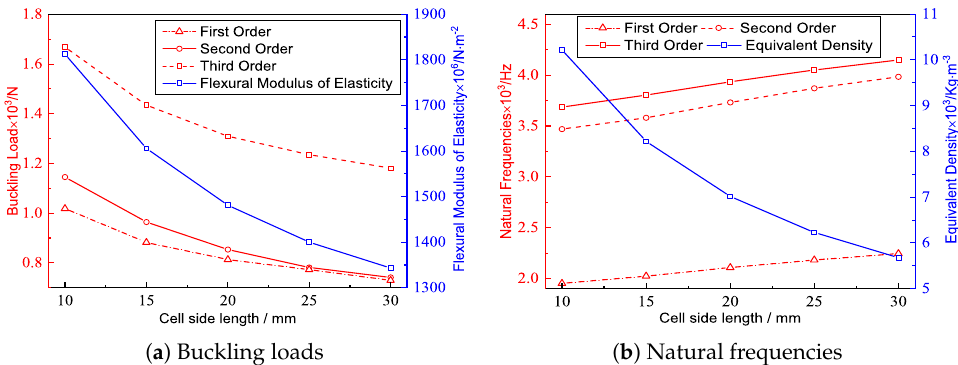
Figure 13. Effects of the cell side lengths on the buckling loads and natural frequencies of the triangular